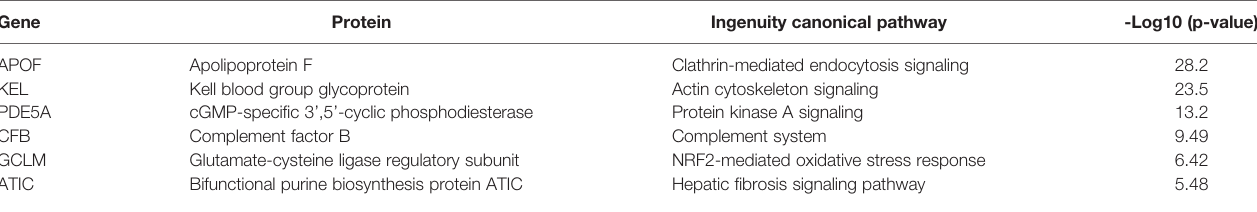
TABLE 2 | The cellular function of the six EV proteins identi fi ed by